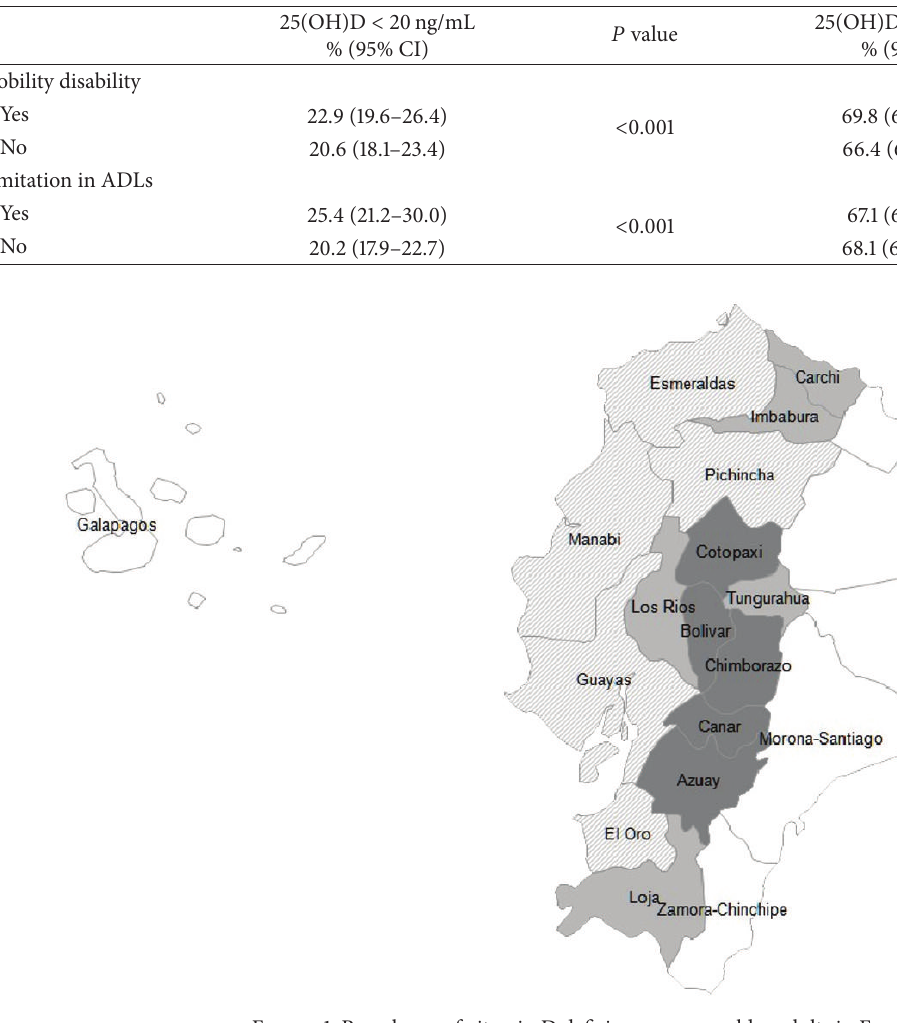
Figure 1: Prevalence of vitamin D deficiency among older adults in